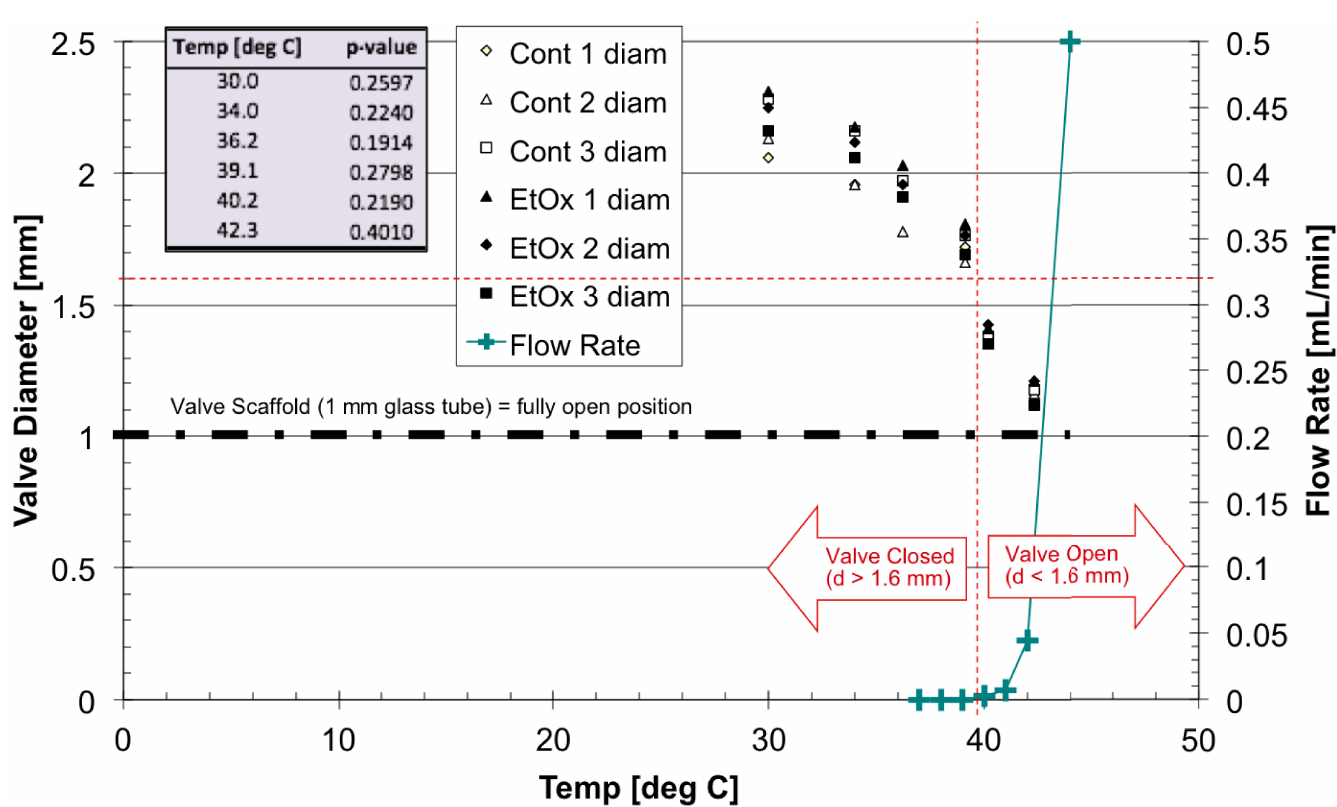
Fig 4. Thermal responsive performance of 30% DMAA pNIPAM valves in caprine amniotic fluid following dehydration, ethylene oxide (EtO) sterilization, then rehydration. P-values of control vs. exposed to EtO sterilization valves indicate that the sterilization procedure does not impact valve performance. ‘Flow Rate’ data (teal color: +) present measured flow rates, based on 80-mmHg hydrostatic head pressure, at various temperatures for a representative valve. Valve diameter data are plotted as black symbols: ■ , ☐ , ◆ , Δ ,